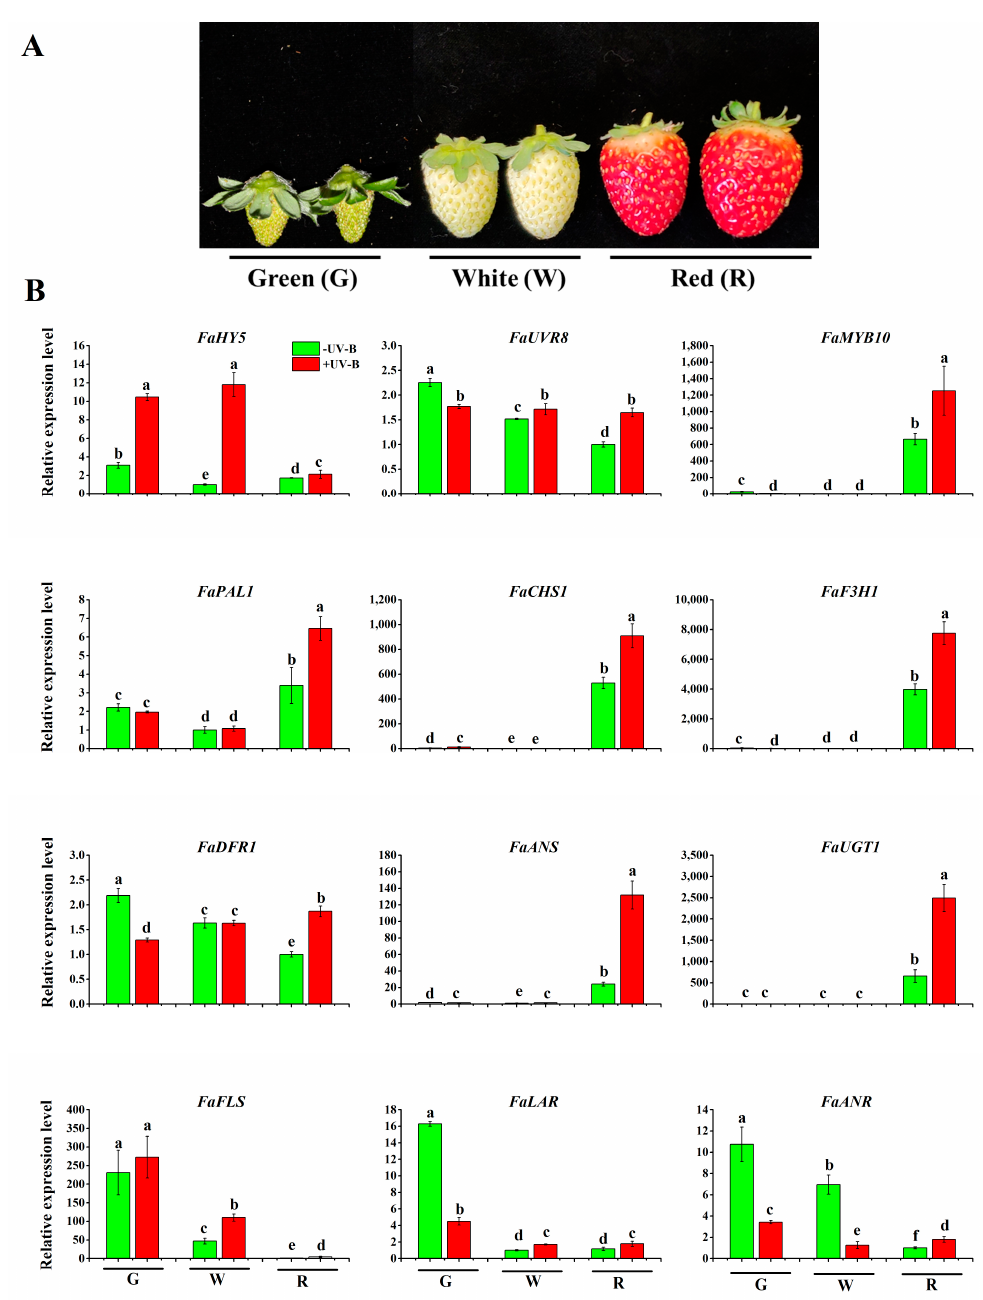
Figure 5. Expression patterns of UV-B signaling pathway and anthocyanin biosynthetic genes in strawberry fruits after UV-B 1 h treatment. ( A ) Fruit images at different stages. ( B ) Comparison of gene expression levels. G: fruit at the green stage; W: fruit at the white stage; R: fruit at the ripe stage; RNA levels were quantified and normalized to the level of FaACTIN . Values are means ± SD of three replicates. The data are based on three biological replicates. * p < 0.05.